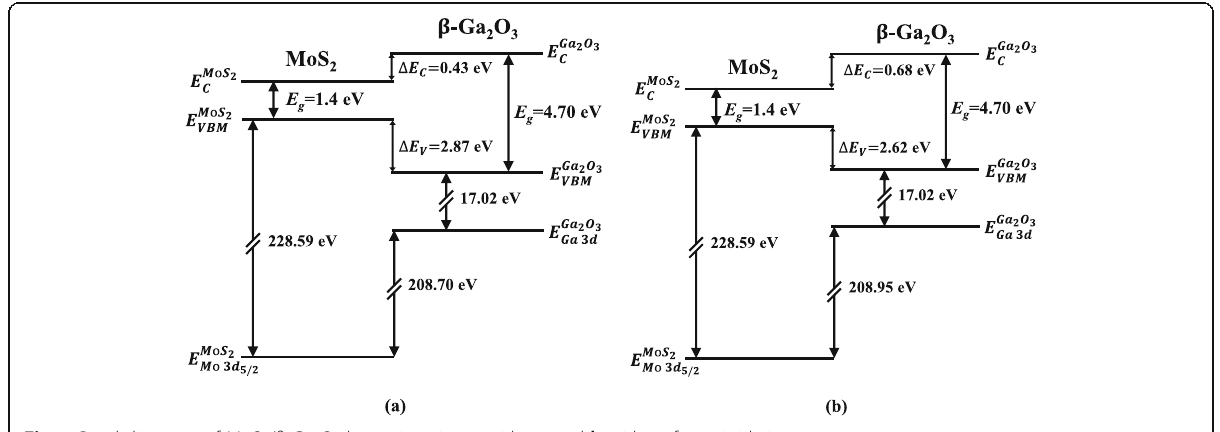
Fig. 5 Band diagrams of MoS 2 / β -Ga 2 O 3 heterojunction a without and b with surface nitridation